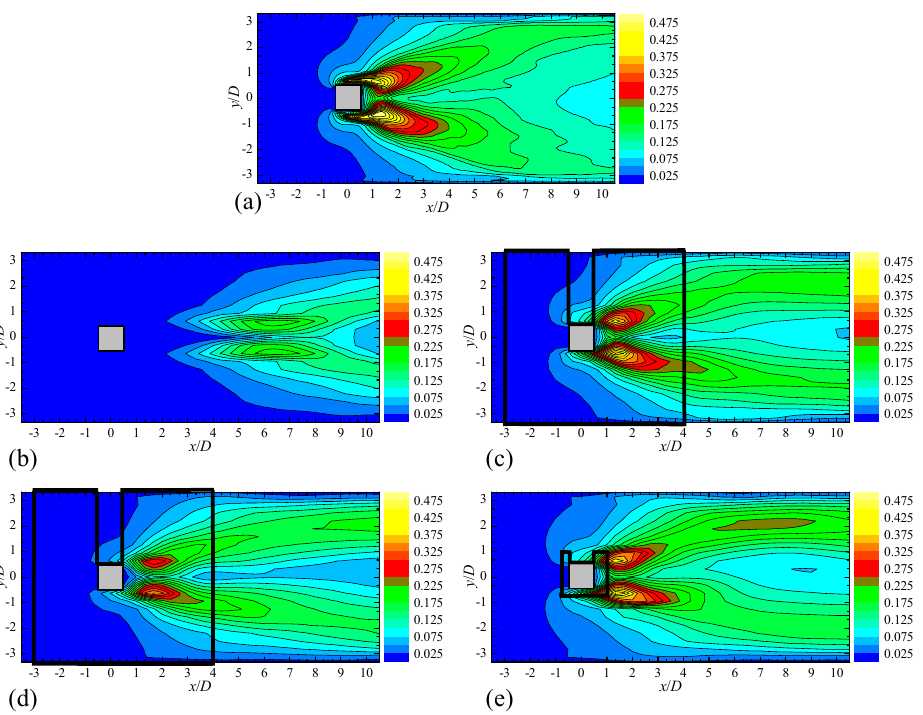
Fig. 5 Comparison of velocity fluctuations u ’ simulation; (c) PIV-MI simulation with full feedback ( A PIV-MI simulation with temporally limited feedback ( A simulation with spatially limited feedback ( A